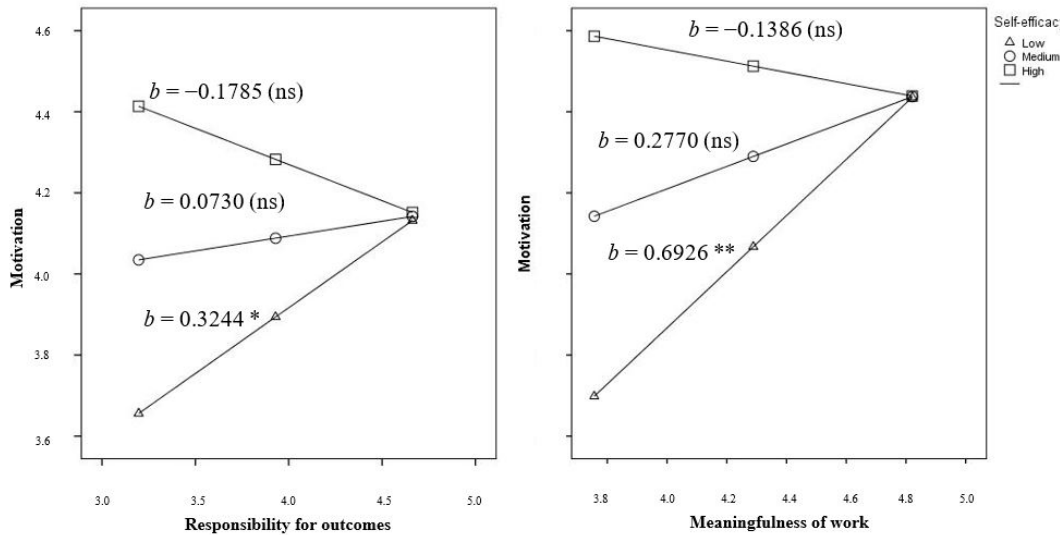
Figure 2. Moderator effect of self-efficacy on the relationship between responsibility for outcomes, meaningfulness of work, and motivation on employees with intellectual disabilities (Note: ** p < 0.001, * p < 0.01).